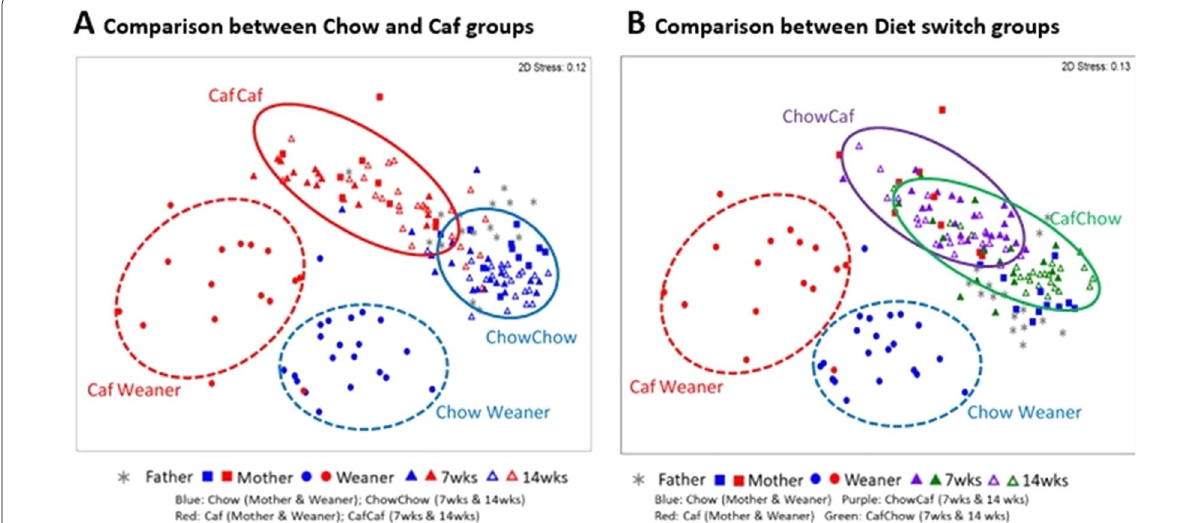
Fig. 3 β-diversity. Non-metric multidimensional scaling (NMDS) plots following square root transformation and Bray–Curtis resemblance of relative abundance data at the OTU level. A NMDS for Weaner (Chow or Caf), 7wks (ChowChow or CafCaf) and 14wks (ChowChow or CafCaf); Father (Chow only), Mother (Chow or Caf) are also shown. B NMDS for Weaner (Chow or Caf), 7wks (ChowCaf or CafChow) and 14 wks (ChowCaf or CafChow); Father (Chow only), Mother (Chow or Caf) are also shown. Chow: chow diet; Caf: Cafeteria diet; ChowChow: maternal chow diet and postnatal